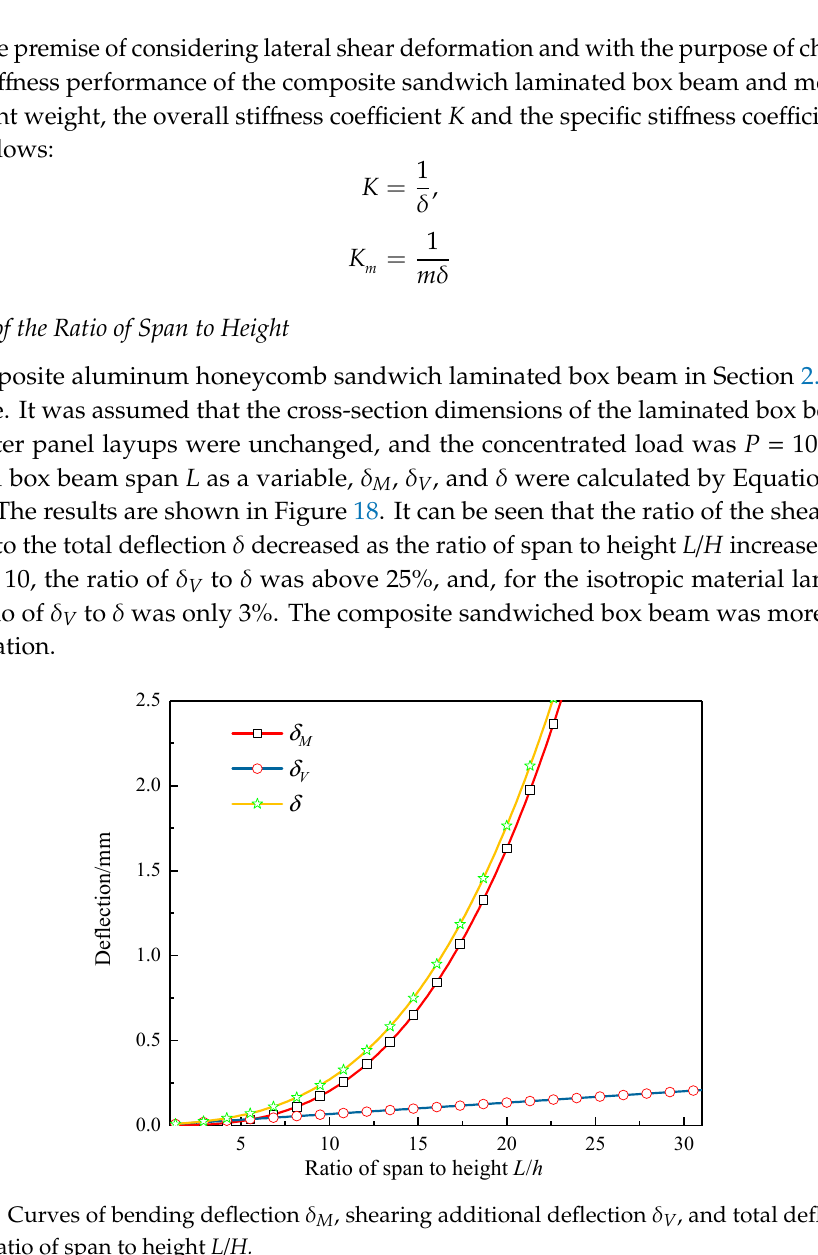
Figure 17. The stress clouds of the whole composite sandwich laminated box beams under three-point bending failure process. ( a ) Aluminum honeycomb core; ( b ) Aluminum foam core.